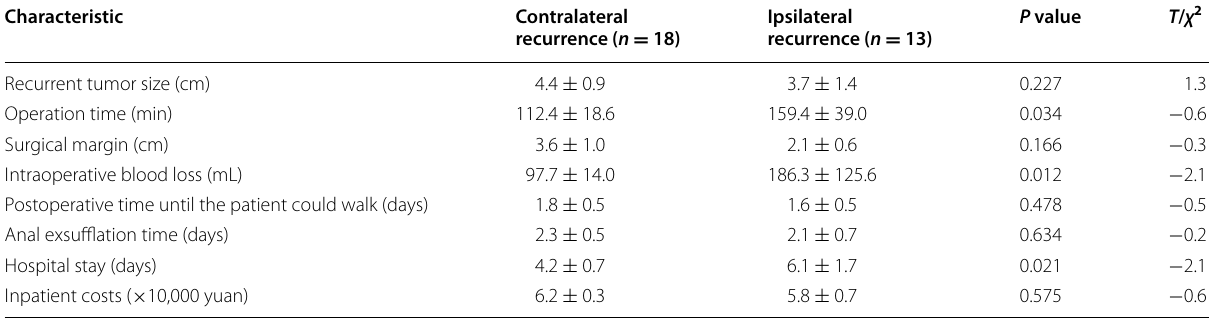
Table 3 Comparison of patients with contralateral and ipsilateral recurrence after laparoscopic